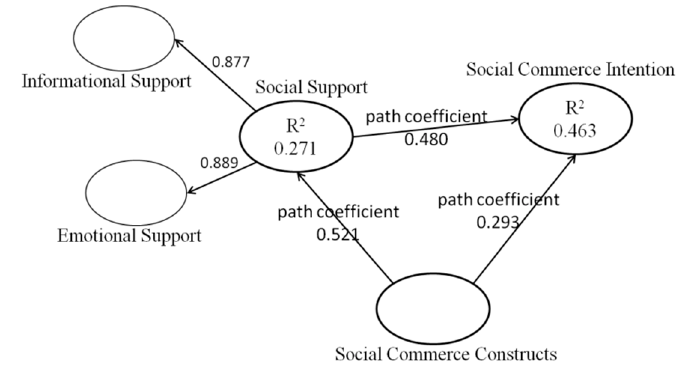
Figure 2. Path diagram of social commerce intention.